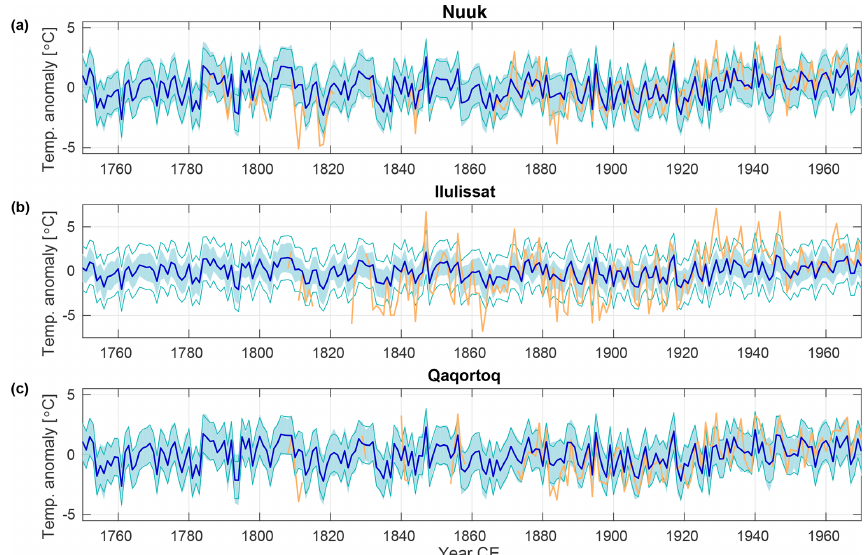
Figure 5. Time series of November–April (sum50) temperature for observed (yellow) and reconstructed ensemble mean (sum50, eight ice cores) (dark blue) from (a) Nuuk, (b) Ilulissat and (c) Qaqortoq. Light-blue shading is the 1 σ spread of the reconstructed temperature, and the green lines indicate the RMSE between the observed and reconstructed